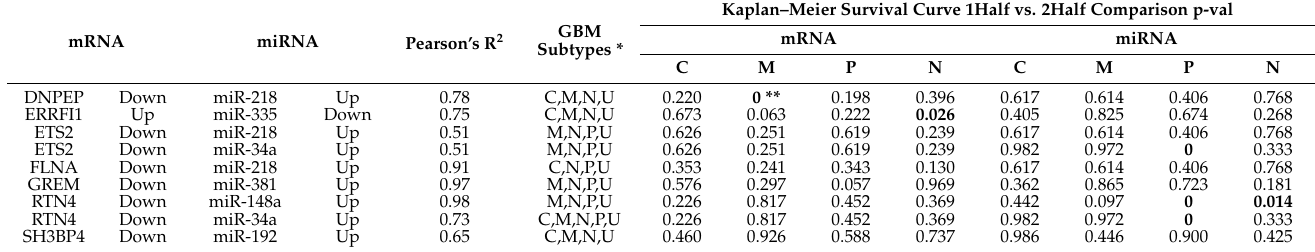
*—Glioblastoma subtypes for which an inverse correlation of miRNA/mRNA levels was found. **—Kaplan–Meier survival p -value < 0.05 are highlighted in